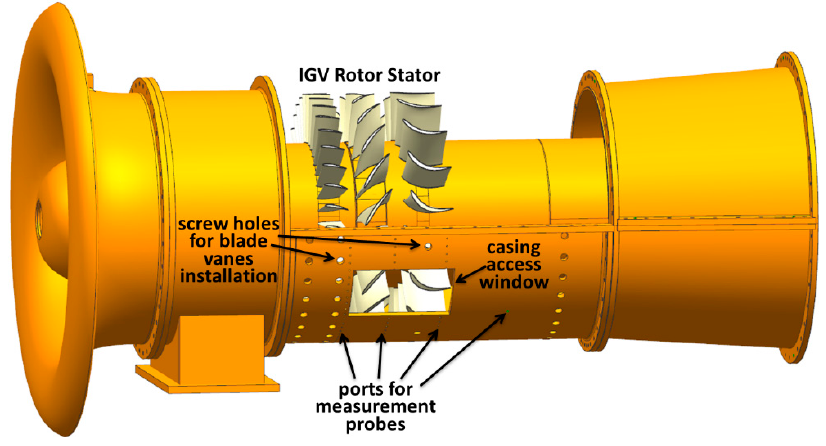
Figure 1. The low-speed large-scale axial compressor test facility of Beihang University.